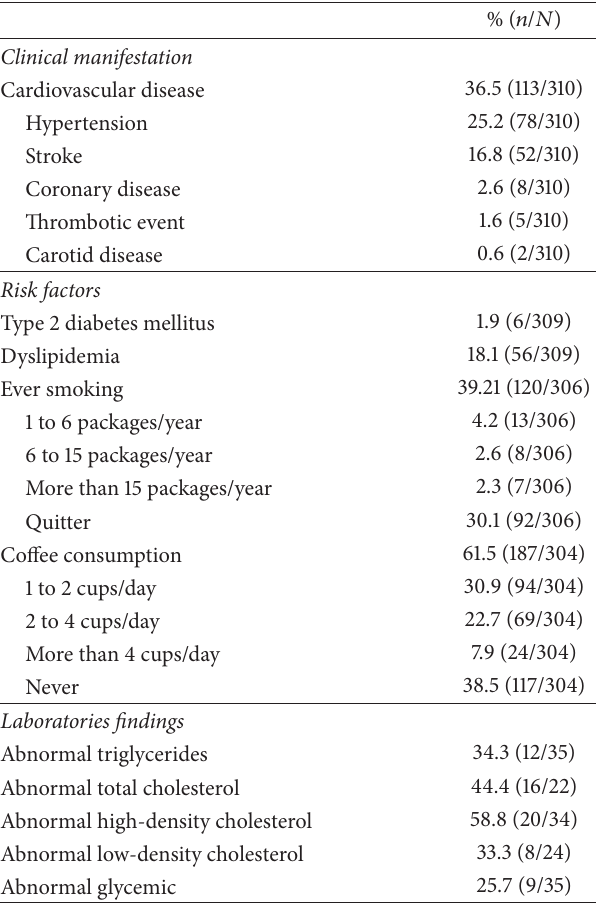
Table 2: Cardiovascular disease characteristics of 310 patients with